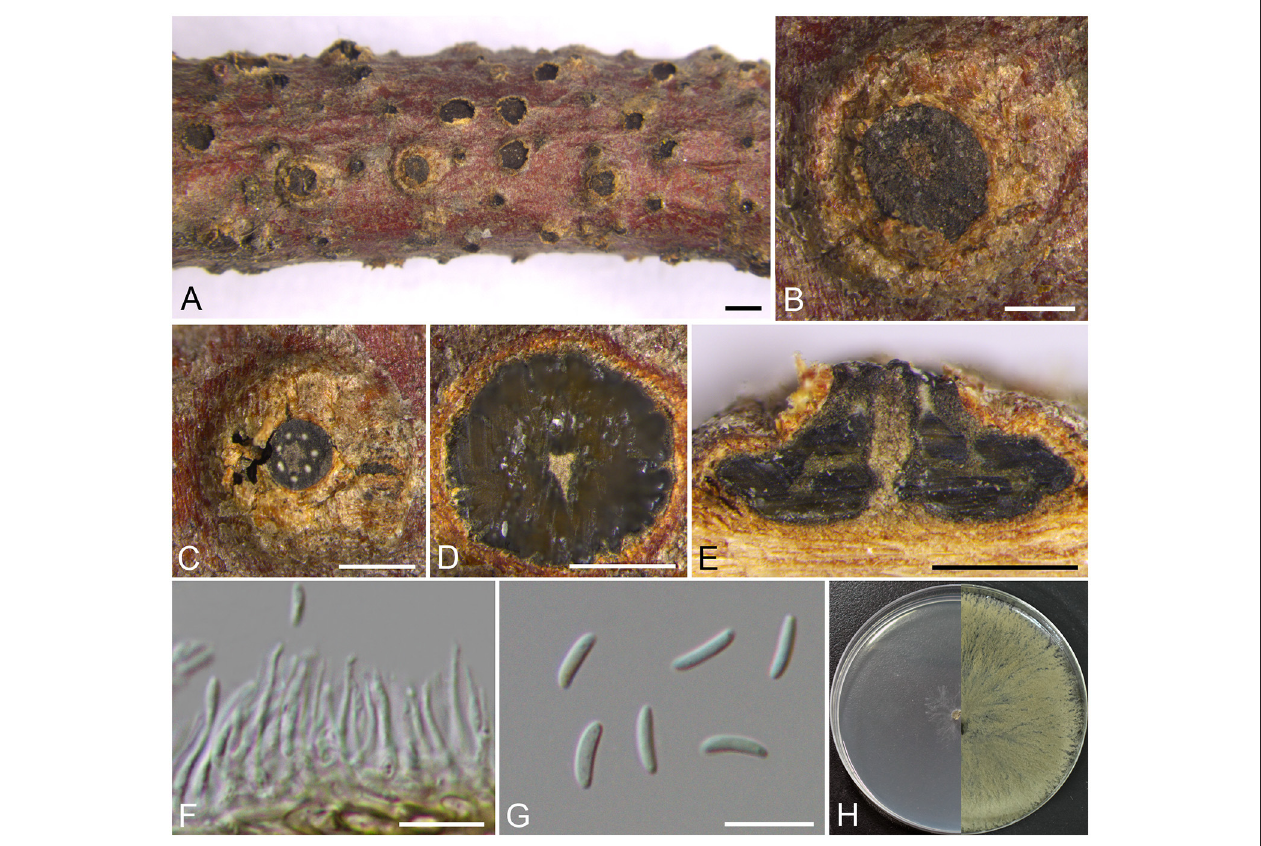
FIGURE 5 | Morphology of Cytospora verrucosa (BJFC CF2019882). (A–C) Habit of conidiomata on twig. (D) Transverse section of conidioma. (E) Longitudinal section through conidioma. (F) Conidiophores and conidiogenous cells. (G) Conidia. (H) Colonies on PDA at 3 days (left) and 30 days (right). Bars: (A) = 1mm; (B–E) = 500 µ m; (F,G) = 10 µ